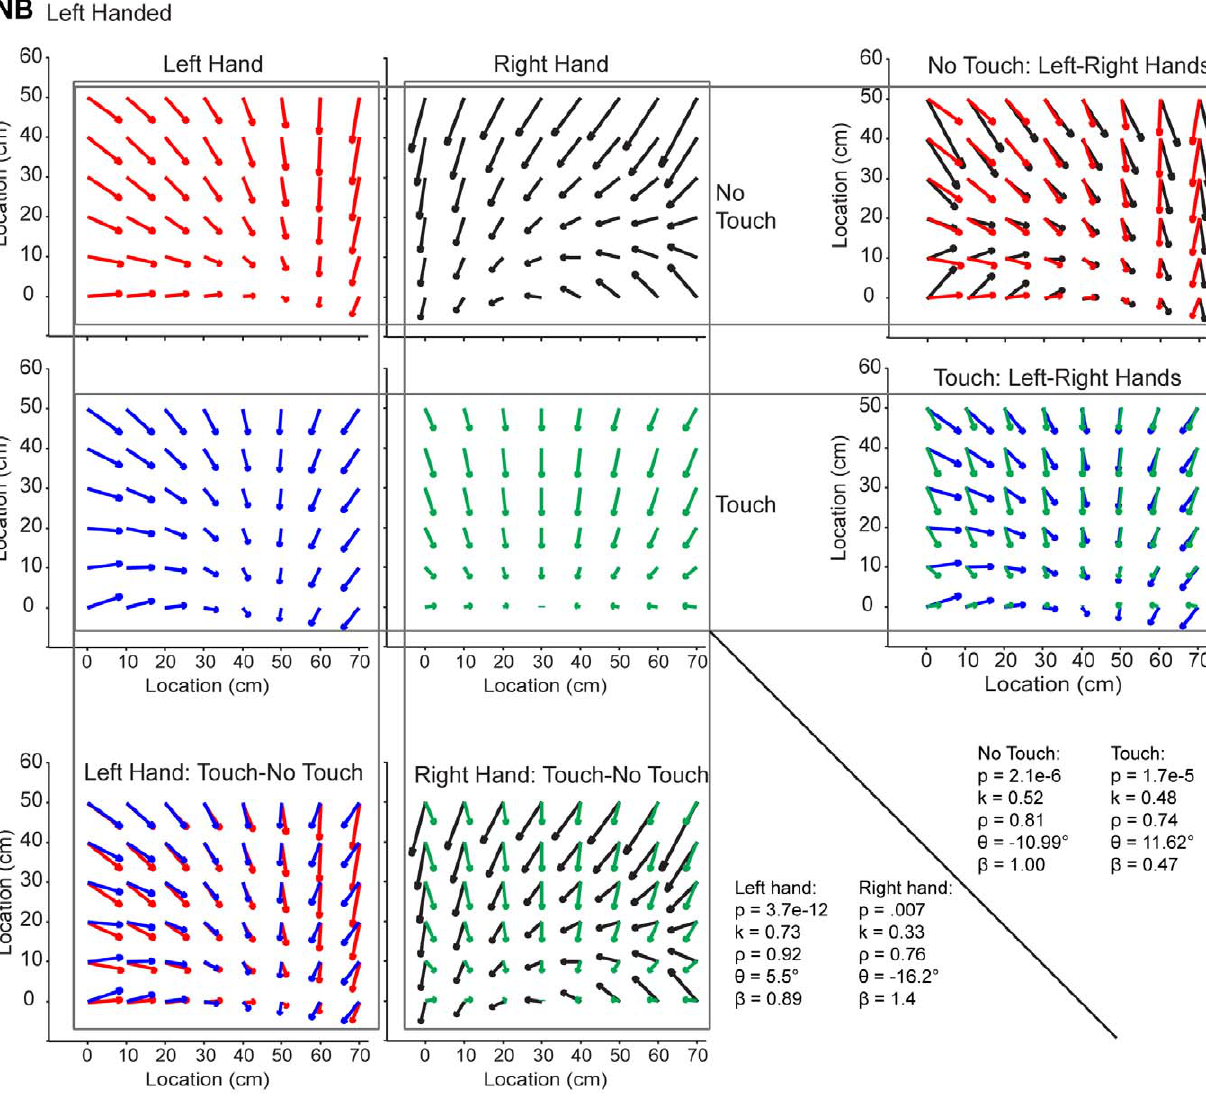
Figure 3. Similarity of Pattern of Errors Across Hands and Conditions. Distribution of errors from one left-handed subject for both hands and both tactile feedback conditions. The text in the right bottom corner represents the resulting values from the K-S test and vector correlation analysis for each of the comparisons in the figure.